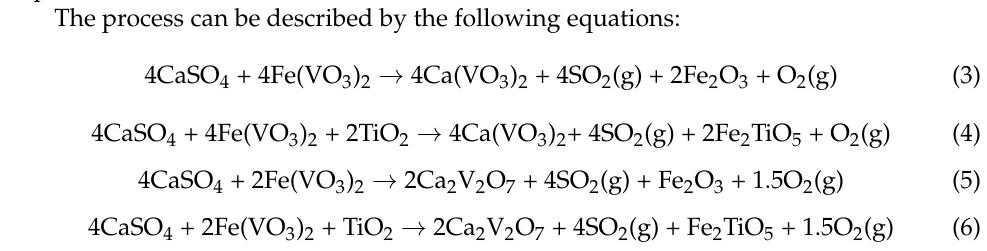
Figure 6. TG curves of the vanadium sludge with 1% CaCO 3 additive and pure CaCO 3.